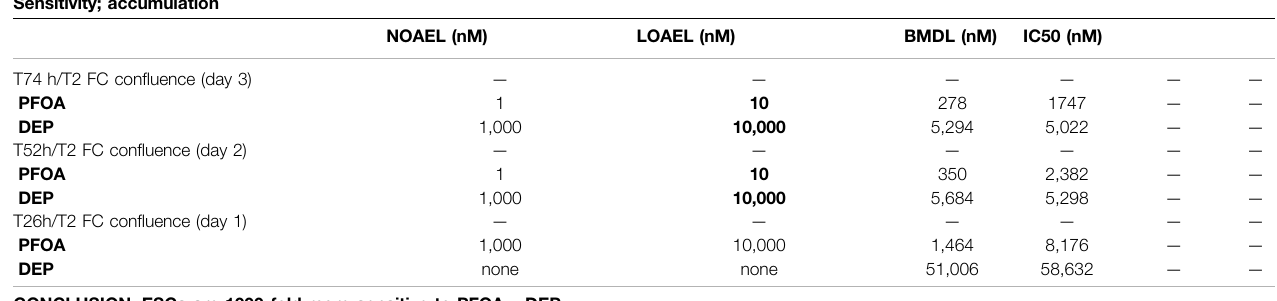
TABLE 1 | Summary of dose- and time-dependent effects of toxicant stress on FUCCI-ESCs. Sensitivity; accumulation